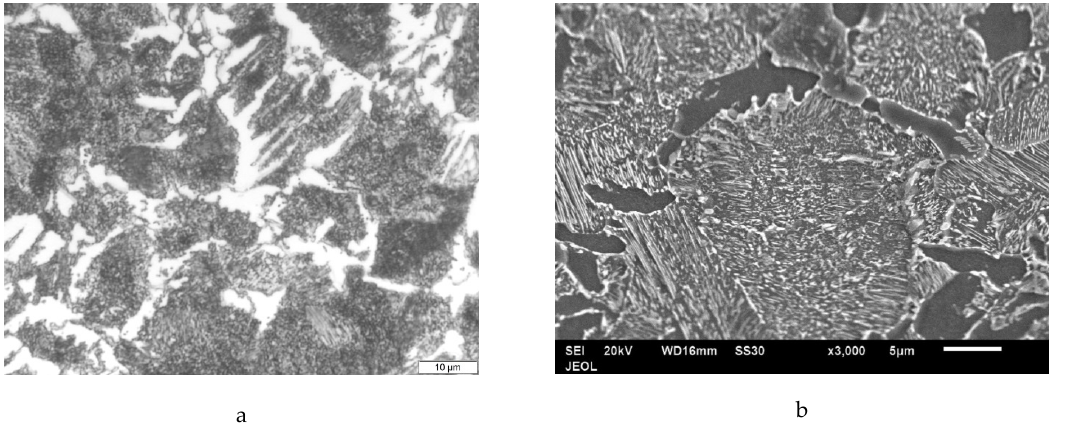
Figure 4. ( a ) Optical micrograph of tempered steel it is composed of ferrite (white) and tempered martensite (dark). ( b ) Secondary electron image of the dark area in optical micrograph (tempered